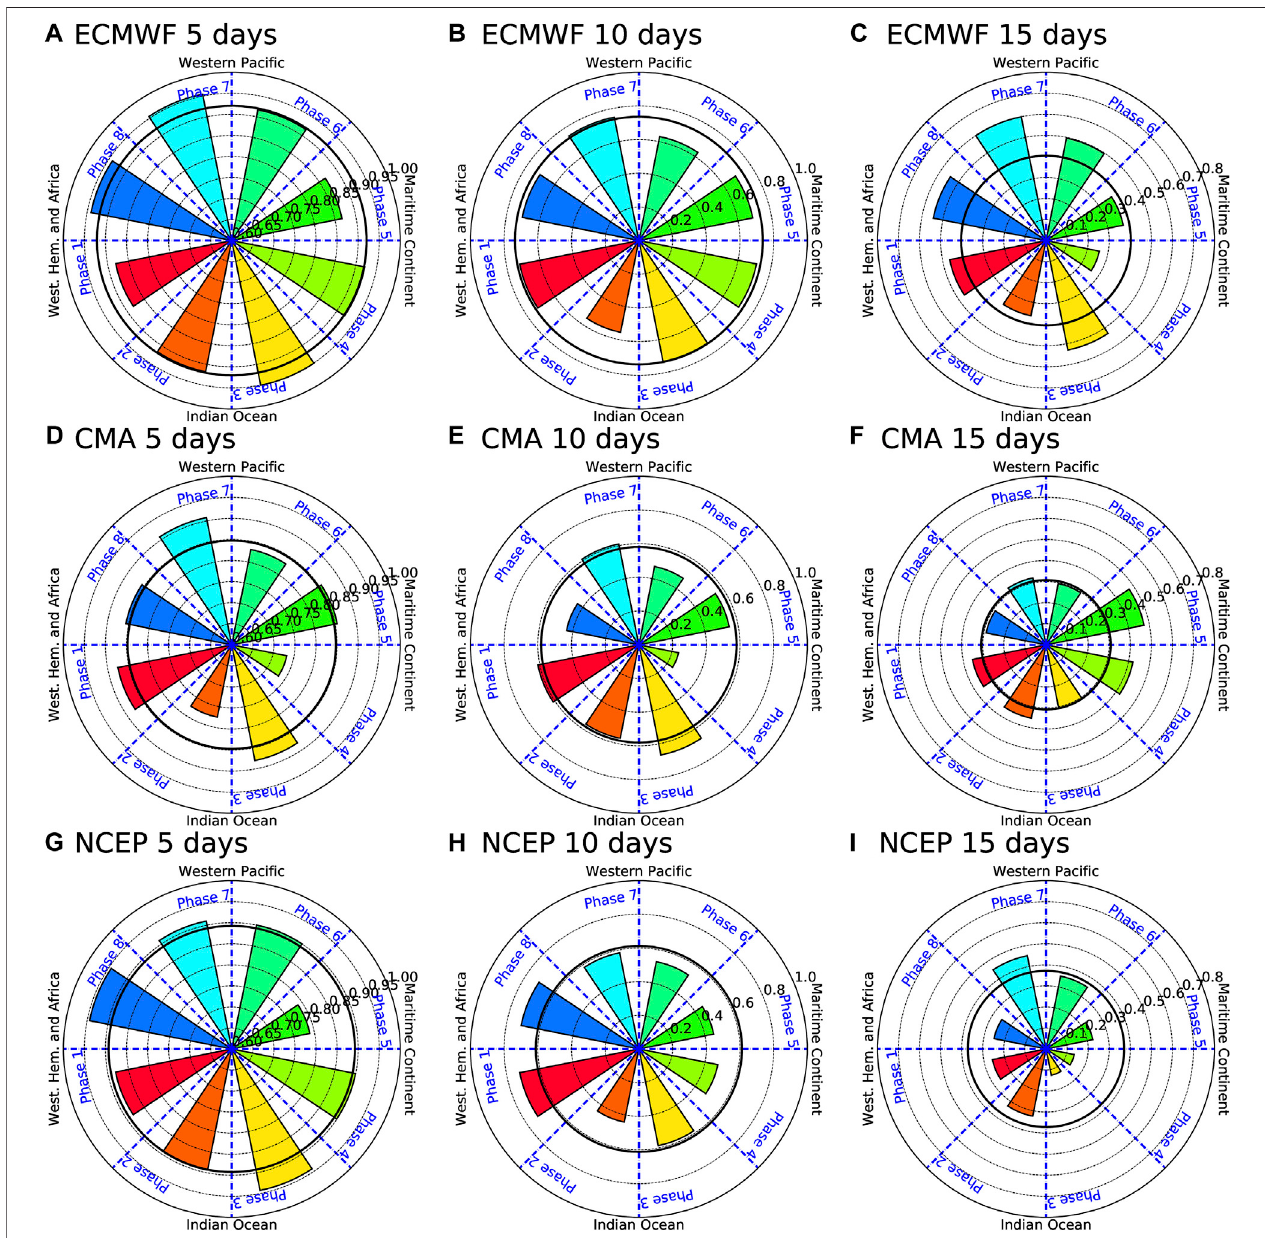
FIGURE 8 | Same as Figure 7 but for the initial day in the negative Arctic Oscillation (AO) phase. Left (A, D, and G) , middle (B, E, and H) , and right (C, F, and I) panels are for the forecast days of 5, 10, and 15 days, respectively.